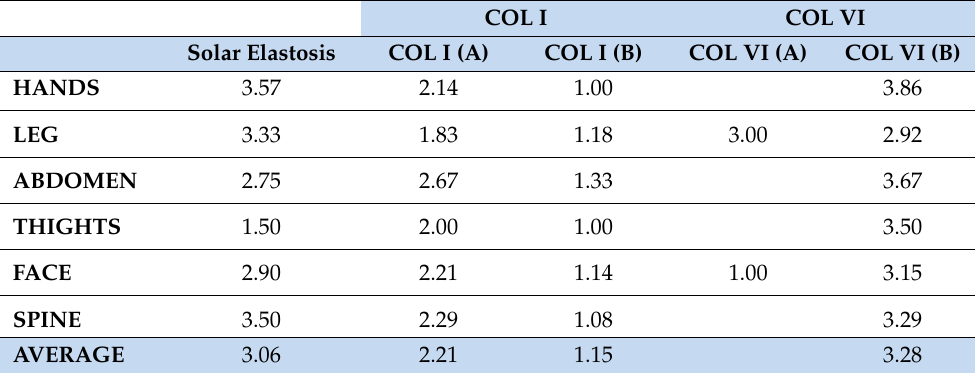
Table 1. Average expression of COL I and COL VI between the epidermis and solar elastosis (index A), and along the dermis (index B), per body part. Results are expressed as the average of the degree of severity of solar elastosis per body part. COL I COL VI Solar